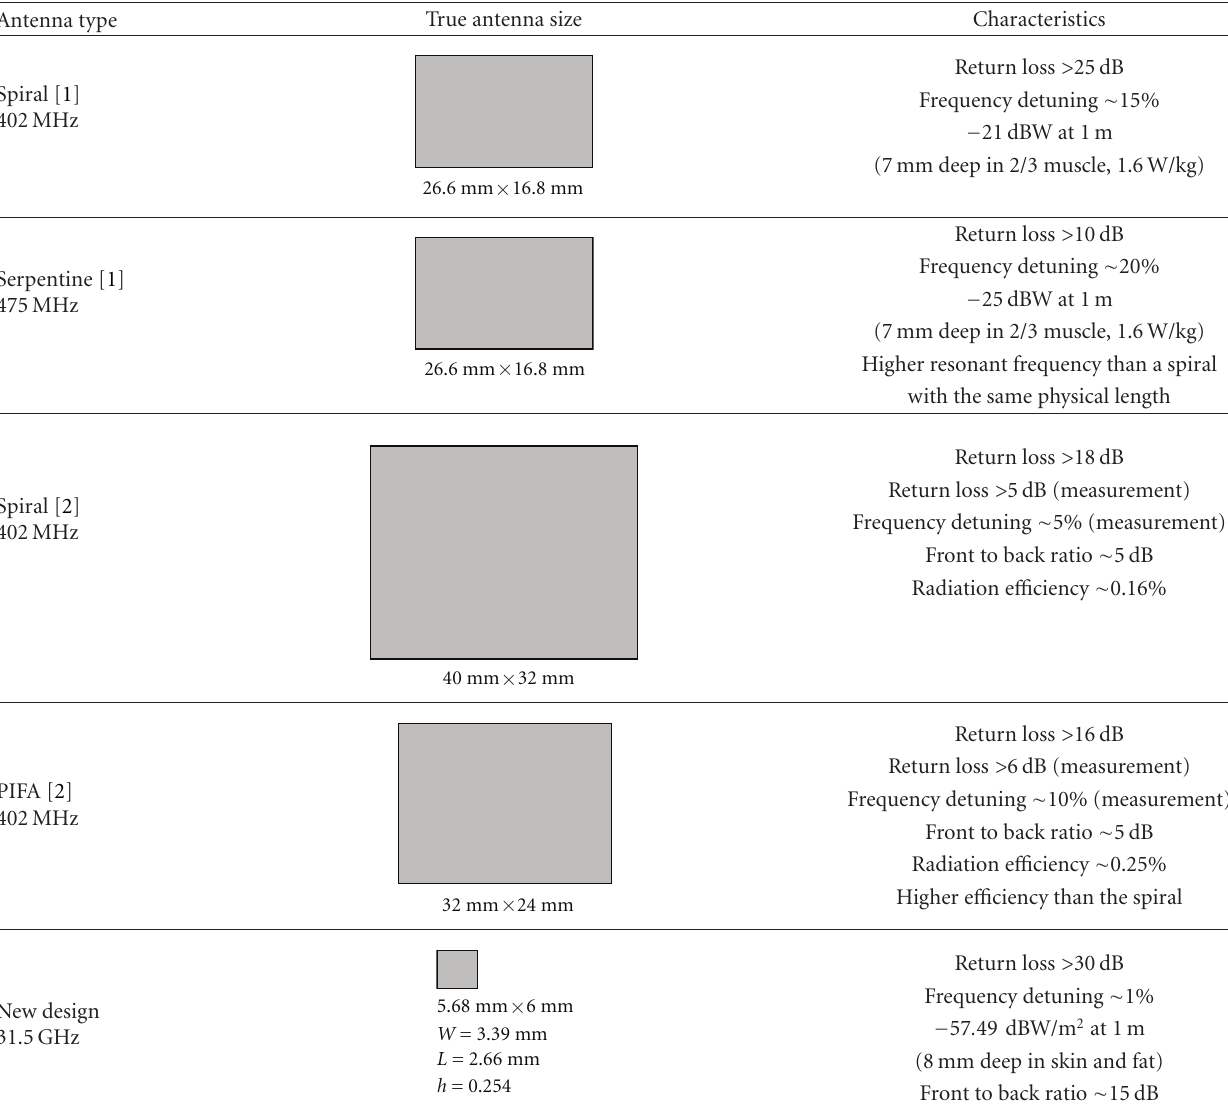
Table 2: Comparison of five di ff erent antennas designed for medical implants. The size of our antenna is governed by the dimensions of the ground